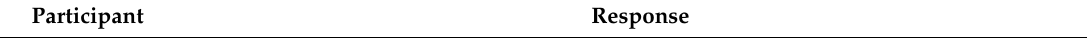
Table 4. Free text responses regarding learning from the GP Shared Care Continuing Professional Development (CPD) Event.